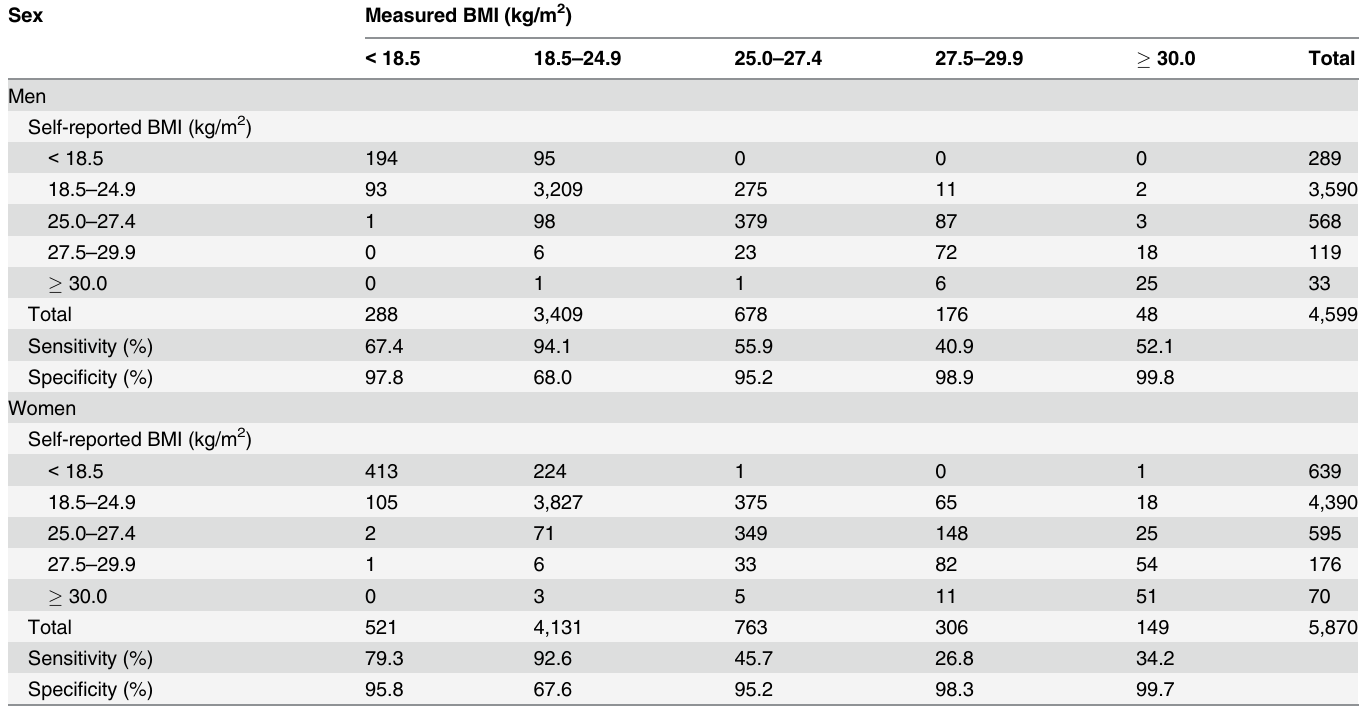
Table 5. Classification of survey participants according to measured and self-reported body mass index and test values of diagnosis based on self-reported values from the National Nutrition Survey, 1986.